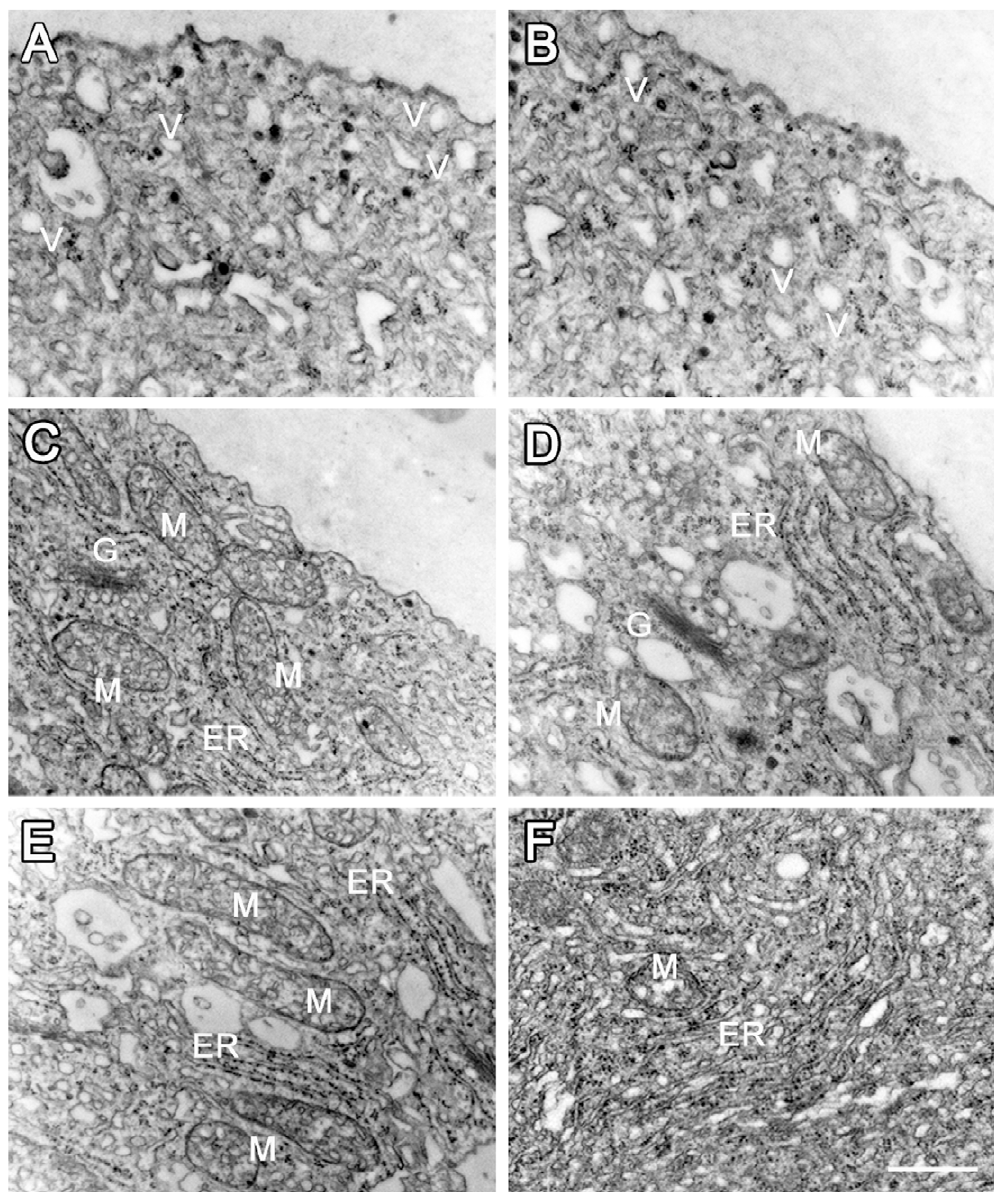
Figure 4. TEM analysis of cytoplasmic organization and organelle ultrastructure after anti-CaM treatment. A, Tip region of control pollen tube with abundant vesicles. B, Tip region in pollen tube after anti-CaM treatment, showing no obvious change in cytoplasmic organization. C, Mitochondria with electron-dense matrix and well-developed cristae in control pollen tube. D, Mitochondria without obvious abnormalities in ultrastructure upon anti-CaM treatment. E, Flat, tightly packed ERs with many attached ribosomes in control pollen tube. F, ERs with fewer attached ribosomes after anti-CaM treatment. Bar=0.5 m m; G, Golgi stack; M, mitochondria; V, vesicle; ER, endoplasmic reticulum.